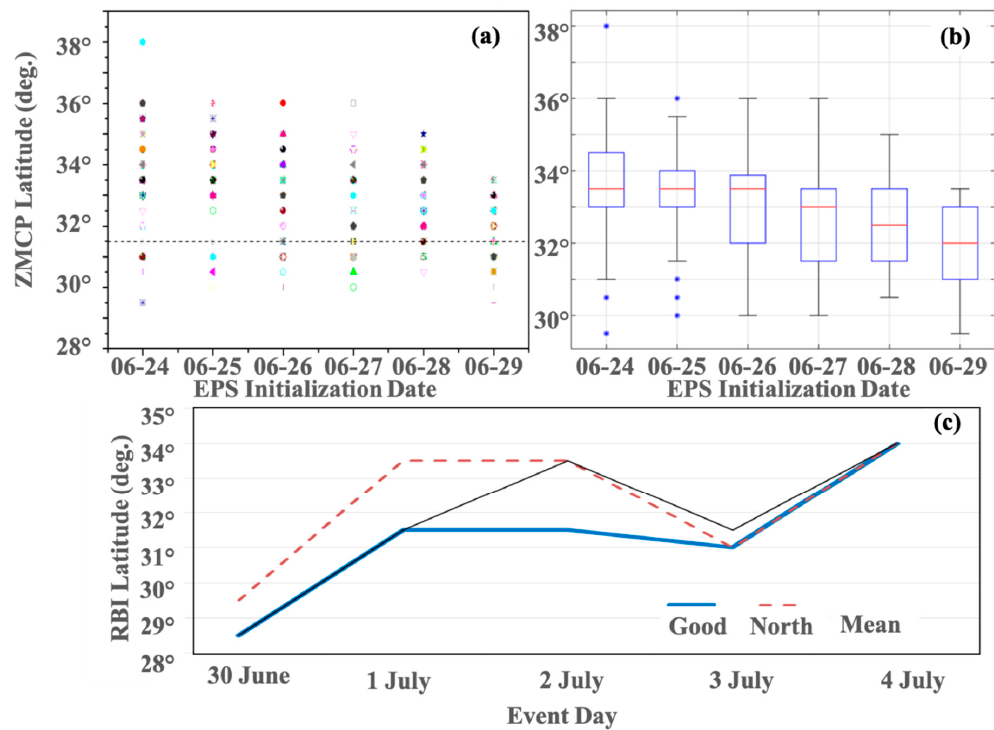
Figure 8. Time evolution of the ZMCP and the RBI forecast for the ECMWF EPS. ( a ) Forecasted event ZMCP for individual EPS members (colored points) and ( b ) statistical distribution of forecasted event ZMCP for consecutive daily EPS runs initialized 1200 UTC 24 June to 29 June 2016. Observed event ZMCP is represented by the black dashed line in panel ( a ). Red line in panel ( b ) is the EPS median ZMCP, edges of the boxes represent the 25th and 75th quartiles, whisker edges represent the 5th and 95th quartiles, and blue points represent outliers. ( c ) Daily variability of the RBI forecasted by the five member GOOD subgroup (‘G’, blue solid line), the five member NORTH subgroup (‘N’, red dashed line) and the 51-member ensemble (‘E’, black line) from the ECMWF EPS initialized at 1200 UTC 29 June 2016 for each day during 30 June to 4 July 2016. The regional distribution of precipitation for 1 July further demonstrates this difference (Figure 9).